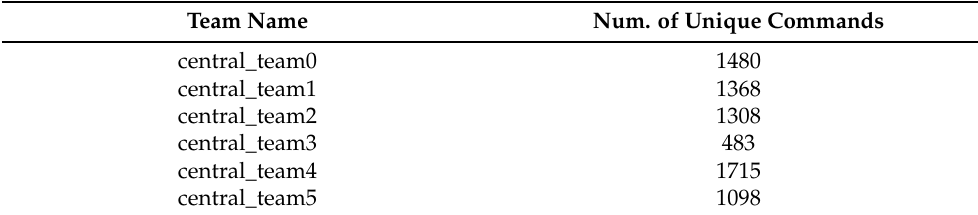
Table 3. Statistics on raw categorical data—Bash History from the CPTC 2019.